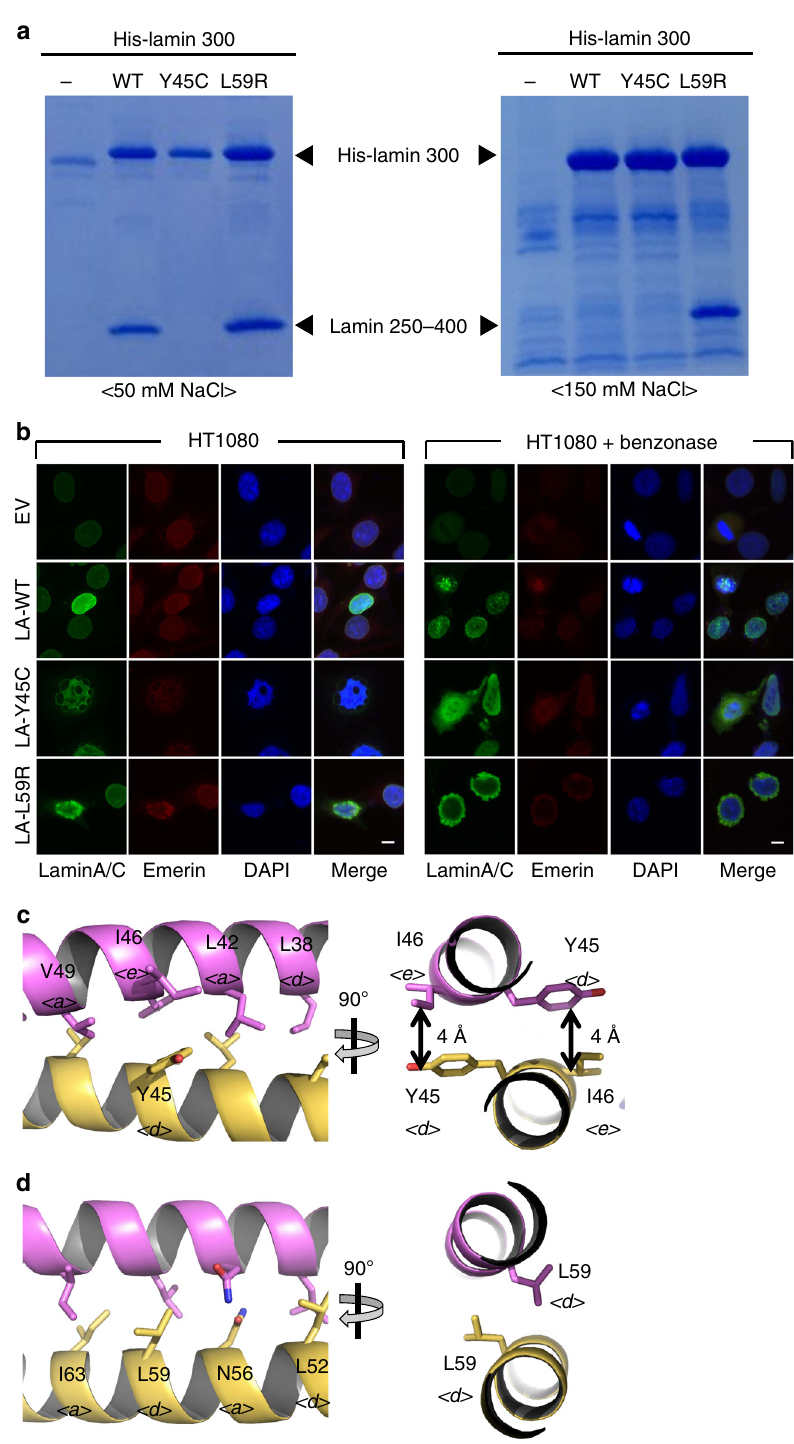
Fig. 8 The laminopathy-related mutations. a Altered eA22 interaction by mutations Y45C or L59R, revealed by in vitro binding assay. Wild-type, Y45C, or L59R mutant proteins of the His-tagged lamin 300 fragment were immobilized on Ni-NTA resin. Lamin 250 – 400 fragments were incubated on the empty ( − ) or His-lamin-bound ( + ) Ni-NTA resins. The resins were pre-equilibrated and washed with the 20 mM Tris-HCl (pH 8.0) buffer containing 50 mM (left) or 150 mM NaCl (right). After washing, the bound proteins were analysed using SDS-PAGE. b Nuclear shapes and distribution of lamin A/C Y45C and L59R mutant proteins. Nuclear morphology was examined using fl uorescence confocal microscopy after transfection of empty vector (EV), wild-type, or Y45C or L59R mutant of lamin A/C ( LA-WT , LA-Y45C , and LA-L59R ) into HT1080 cells with or without treatment of 2.5 U benzonase for 5 min. For visualization of the nuclear membrane, cells were stained with lamin A/C (green), emerin (red) and DAPI for DNA (blue). See also Supplementary Figs. 7 and 8. c , d Structural environment around Tyr45 and Leu59. The orthogonal view of the coiled-coil structure around c Tyr45 and d Leu59 residues are represented. Each Tyr45 residue interacts with Ile46 residue in another protomer (double-headed arrows). Leu59 residues adopt ideal inter coiled-coil interaction. ‘ a ’ , ‘ d ’ , and ‘ e ’ positions of the residues in the heptad repeat are labelled with italic